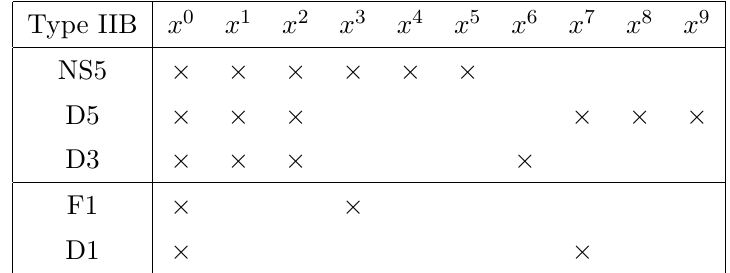
Table 2 . Occupation of space-time directions by NS5, D5, and D3 in Type IIB. The fundamental string F1 induces the electric theory, while the D-string D1 induces the magnetic